Question: Condense the content of this figure into a single sentence.
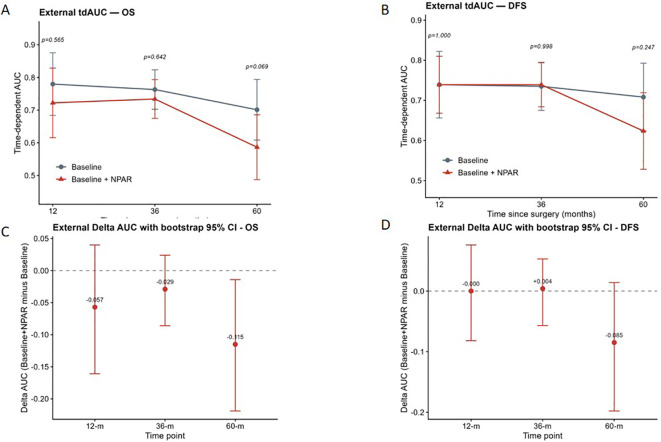
Answer: (A) External validation of time-dependent AUCs for overall survival comparing the baseline model with the baseline plus NPAR model. (B) External validation of time-dependent AUCs for disease-free survival comparing the baseline model with the baseline plus NPAR model. (C) Delta AUC with bootstrap 95% confidence intervals for overall survival in the external validation cohort. (D) Delta AUC with bootstrap 95% confidence intervals for disease-free survival in the external validation cohort.